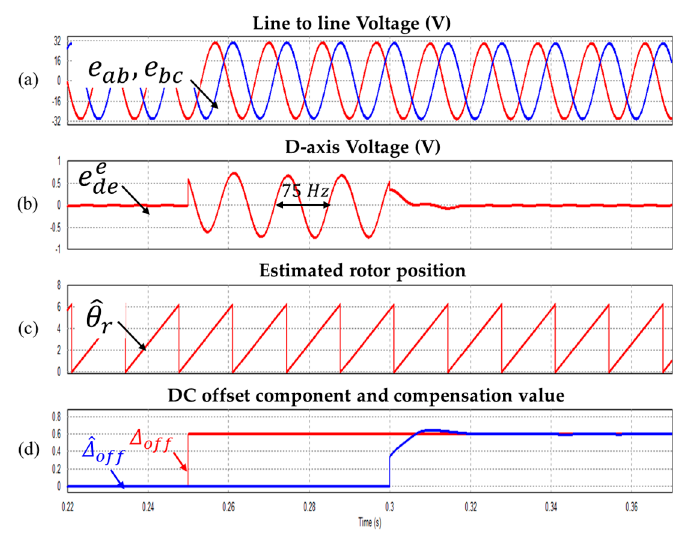
Figure 8. Waveform during injecting the 0.6 V DC offset ( a ) Line to line voltages , Synchronous d-axis voltage ( c ) Estimated rotor position ( d ) DC offset component and compensation value (Operating condition: ω = 1500 r/min). r